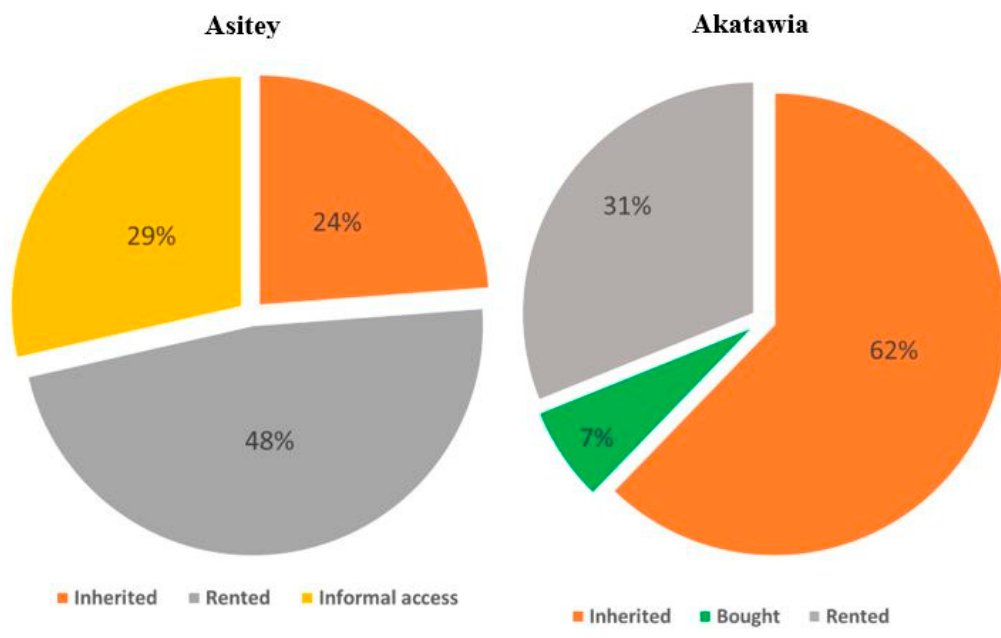
Figure 2. Maize farm plot ownership structure in both